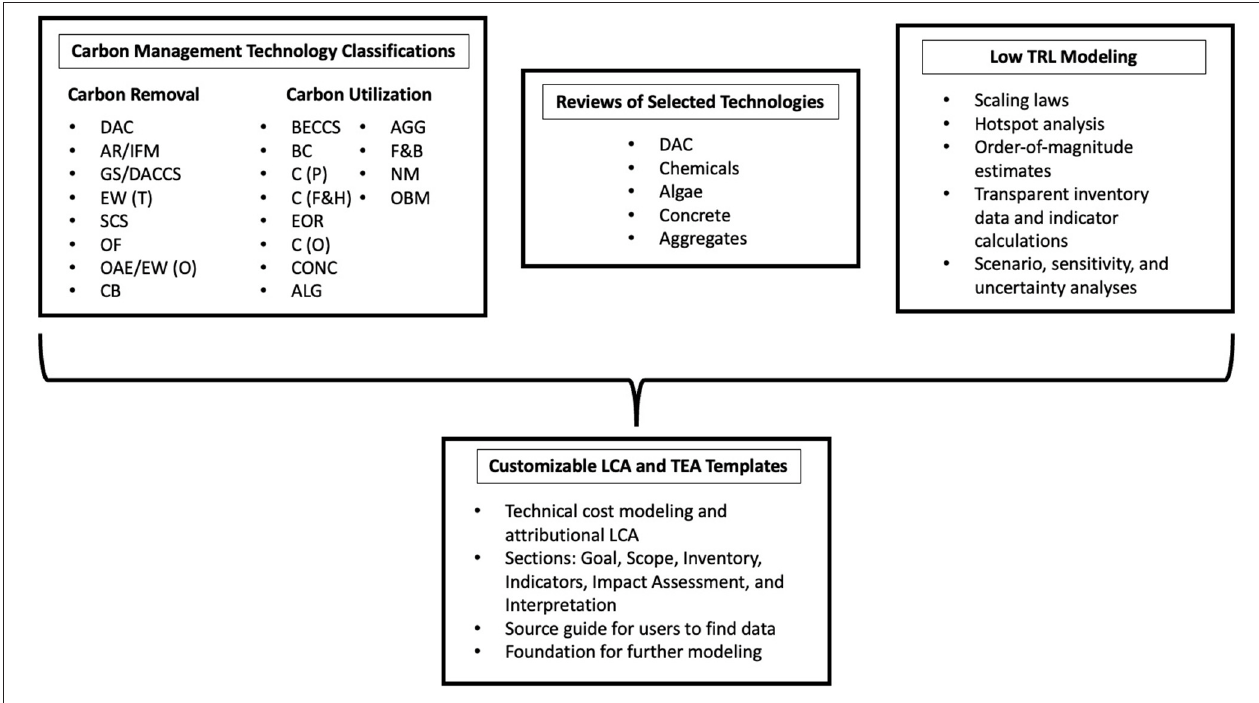
FIGURE 1 | Visual summary of the approach to template